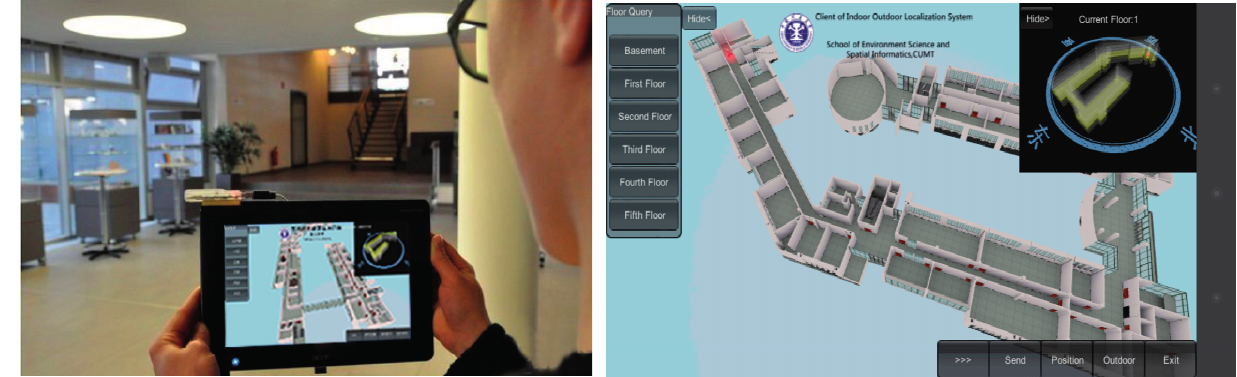
Figure 17. Interface of 3D-indoor Positioning